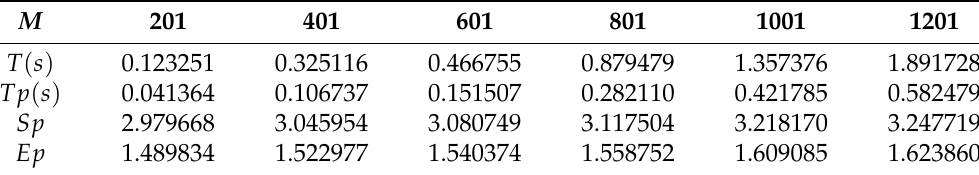
Table 4. CPU time, speed-up ratio and efficiency of the schemes for Example 1. ( α = 0.7, N =